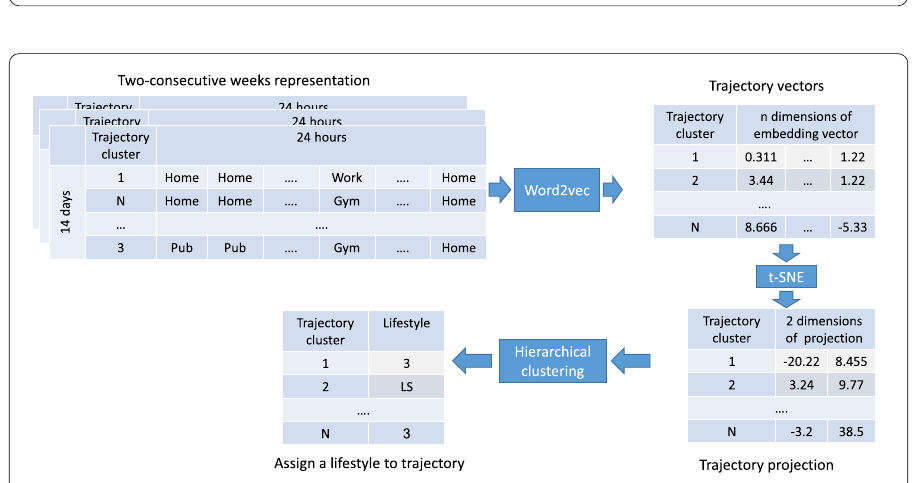
Figure 1 Preprocessing. The preprocessing stage from raw data to clustered trajectories. d is the cell size; A, B, C, D, and O are POIs (O is a POI outside the map); g is the number of trajectories (and days); gT is the number of unique trajectories, where each day is represented by a 24-hour trajectory; and N is the number of trajectory clusters